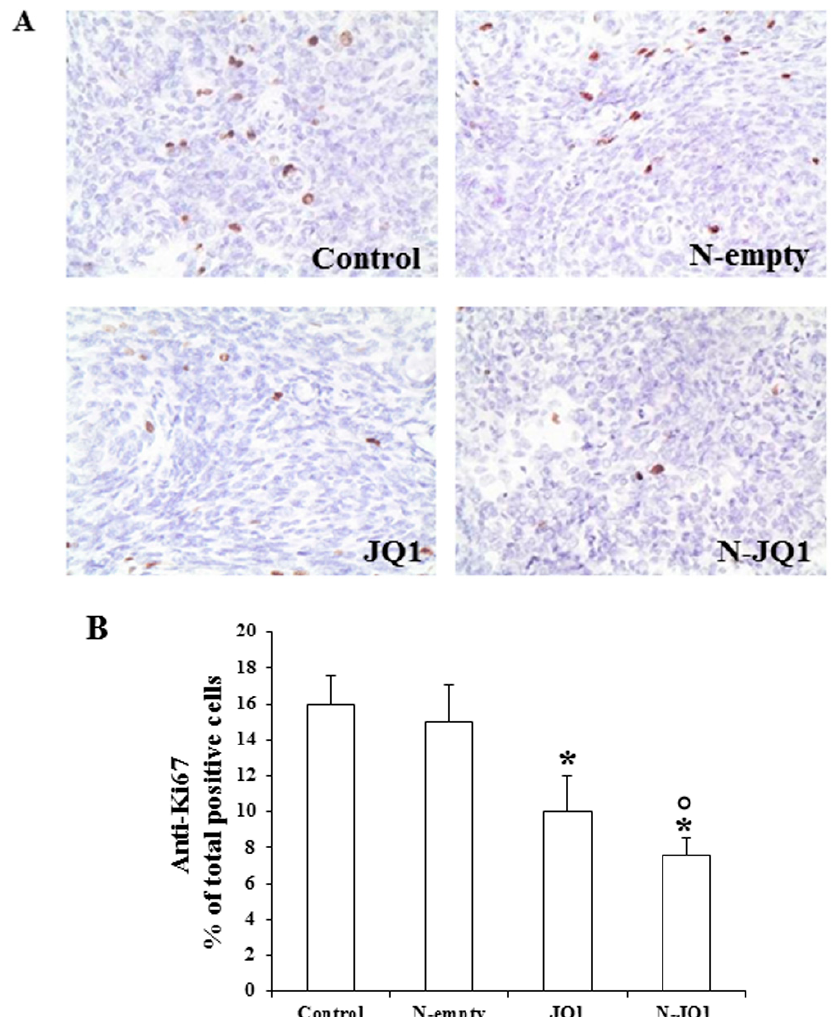
Figure 5. ( A ) A representative image of immunostaining for Ki67 in tumors of each group of animals, treated as described in Methods (200× magnification). ( B ) The percentage of positive over total stained cells for Ki67 in tumors slices are shown in bar graphs.JQ1, JQ1 (20 mg/kg) diluted in PBS + 5% PEG 400 + 5% TWEEN; N-JQ1, nanoparticles containing JQ1 20 mg/Kg; N-empty, unloaded nanoparticles; Control, untreated mice. Values are expressed as means ± SD. * p < 0.05 vs. Control; ° p < 0.05vs. JQ1.